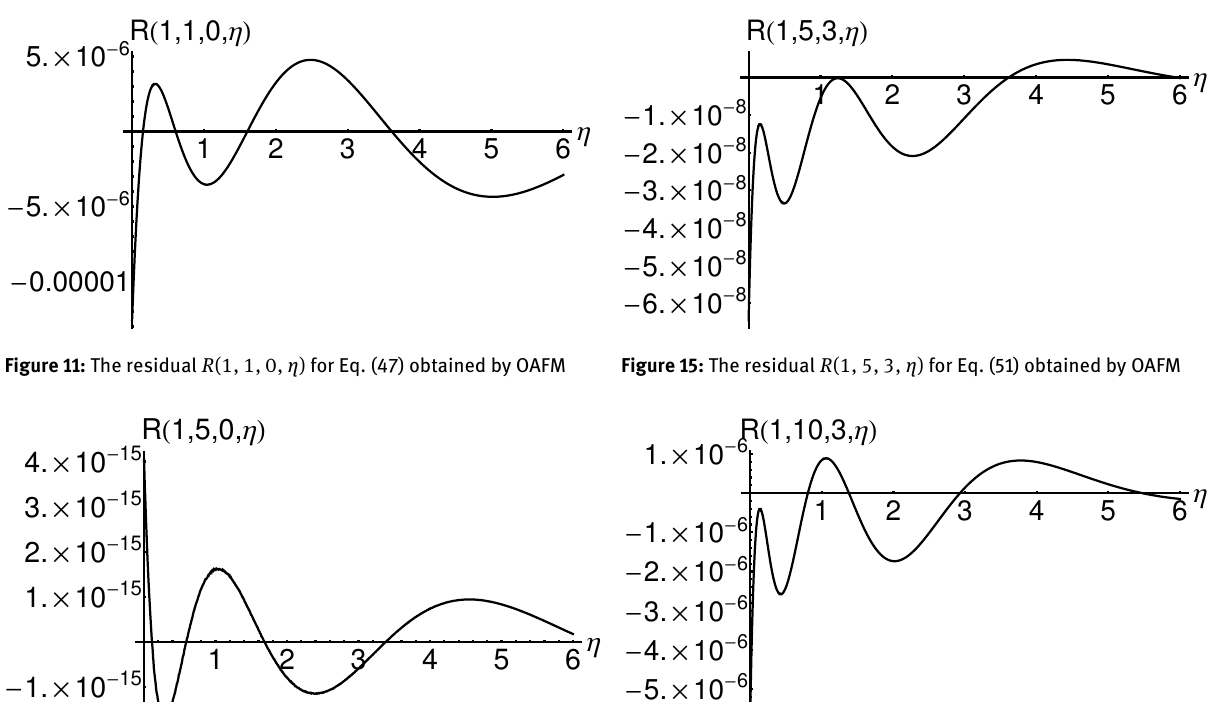
Figure 16: The residual R (1, 10, 3, η ) for Eq. (52) obtained by OAFM